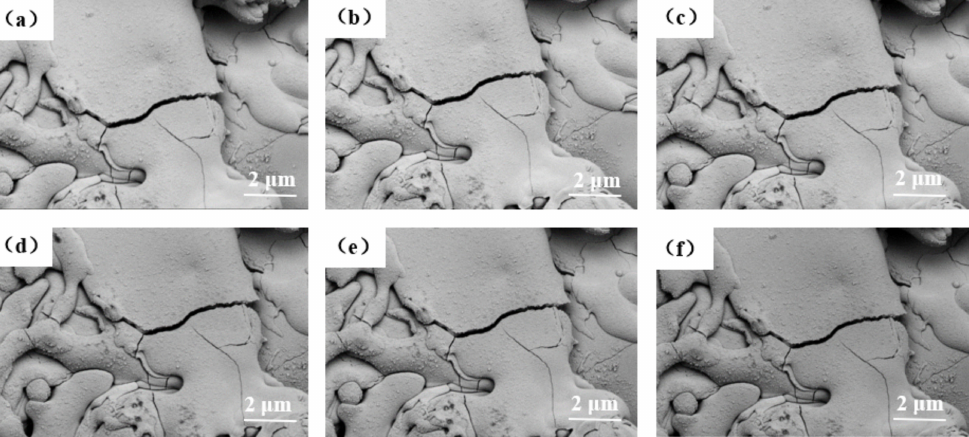
Figure 7. In situ SEM locally enlarged view of a sample held at 766 ◦ C and subjected to a variable loading profile: ( a ) 10 N; ( b ) 50 N; ( c ) 100 N; ( d ) 150 N; ( e ) 250 N; and ( f ) 300